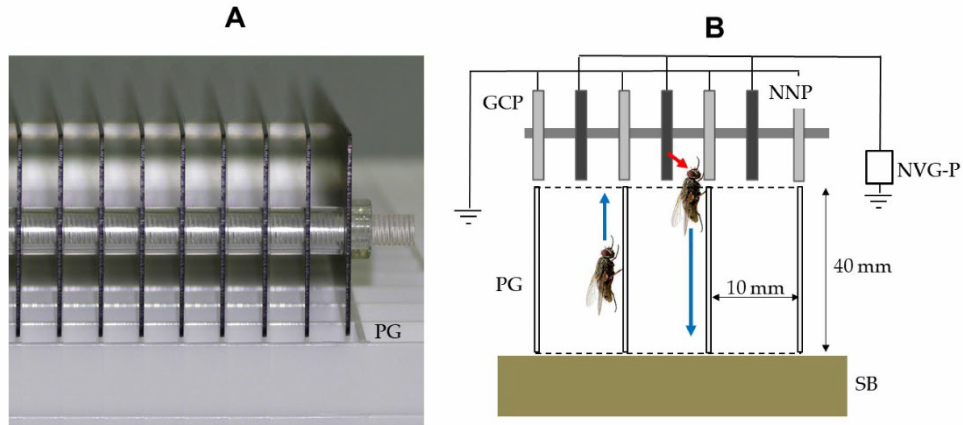
Figure 5. Photograph ( A ) and schematic representation ( B ) of an arc-discharge zapper (ADZ) placed on a plastic grating (PG). The ADZ, which consisted of negatively charged non-insulated conductor (iron) plates (NNPs) linked to a pulse-charge type voltage generator (NVG-P) and grounded conduc- tor plates (GCPs), was placed on a plastic grating (40 mm height, 10 mm square cells). Houseflies anesthetized with CO 2 were transferred to the bottom of the separate cells of the PG placed on a soil bed (SB). After awaking from anesthesia, they climbed along the wall of the cell (blue arrow) and were subjected to an arc discharge (red arrow) from the NNP when they reached the arcing zone, then were knocked downward (blue arrow) by the strong impact of the arc